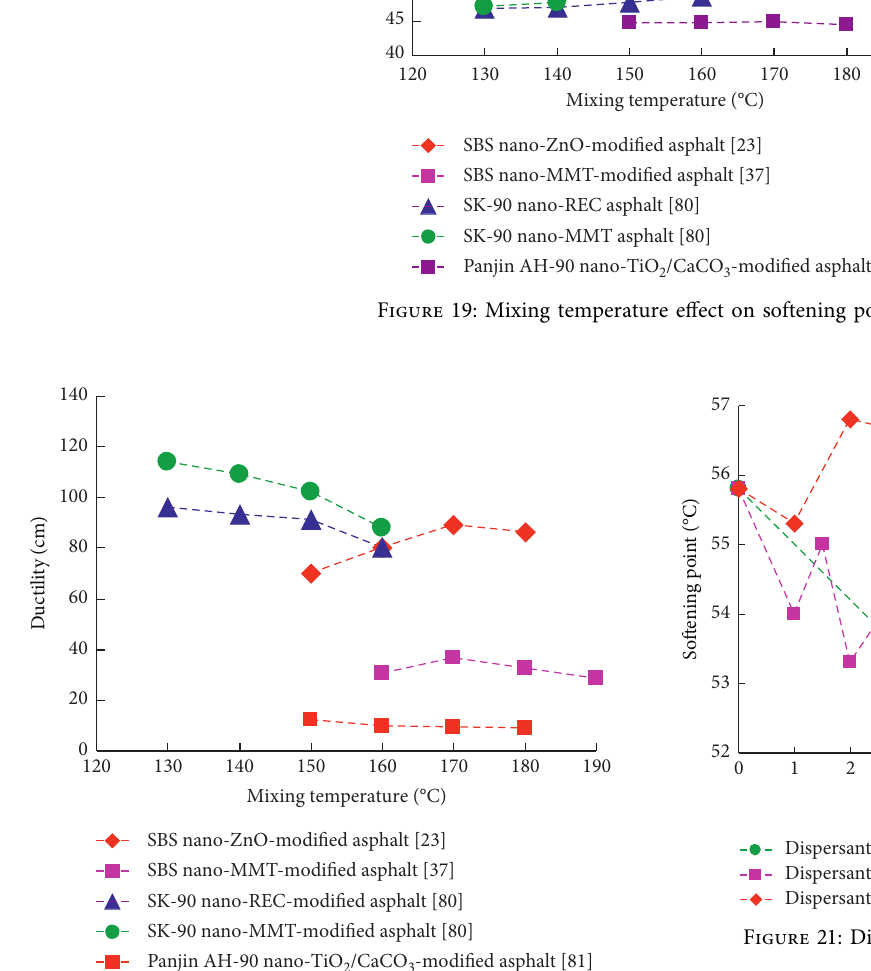
Figure 20: Mixing temperature effect on ductility.